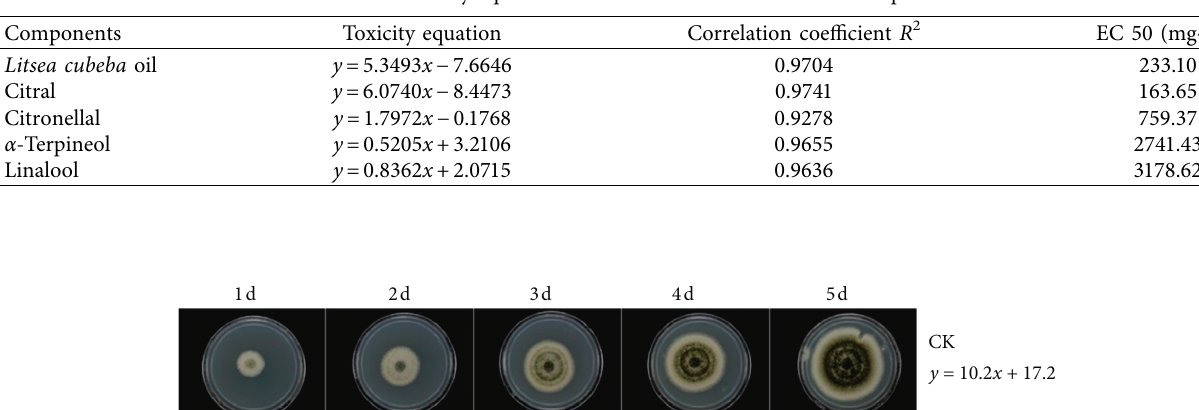
Figure 1: Spore counting method of Litsea cubeba oil and active components. ∗ A: control (untreated); B: citral at 90 mgL − 1 ; C: citral at 180mg L − 1 ; D: citral at 360mg L − 1 ; E: citral at 720mg · L − 1 ; F: citral at 1440mgL − 1 . ∗ a, b, and c show significant differences ( P < 0 . 05). Table 2: The toxicity equation of Litsea cubeba oil and active components.